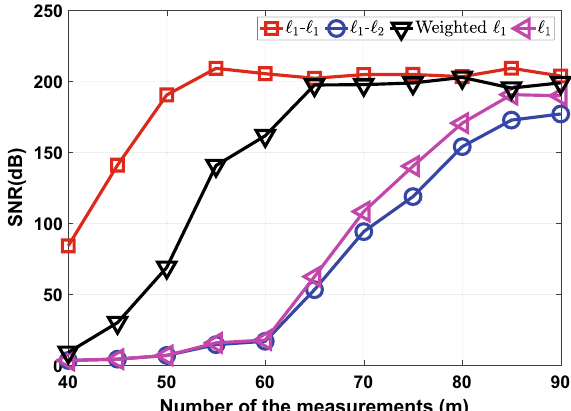
Fig. 3 Recovery performance of four models under different number of the